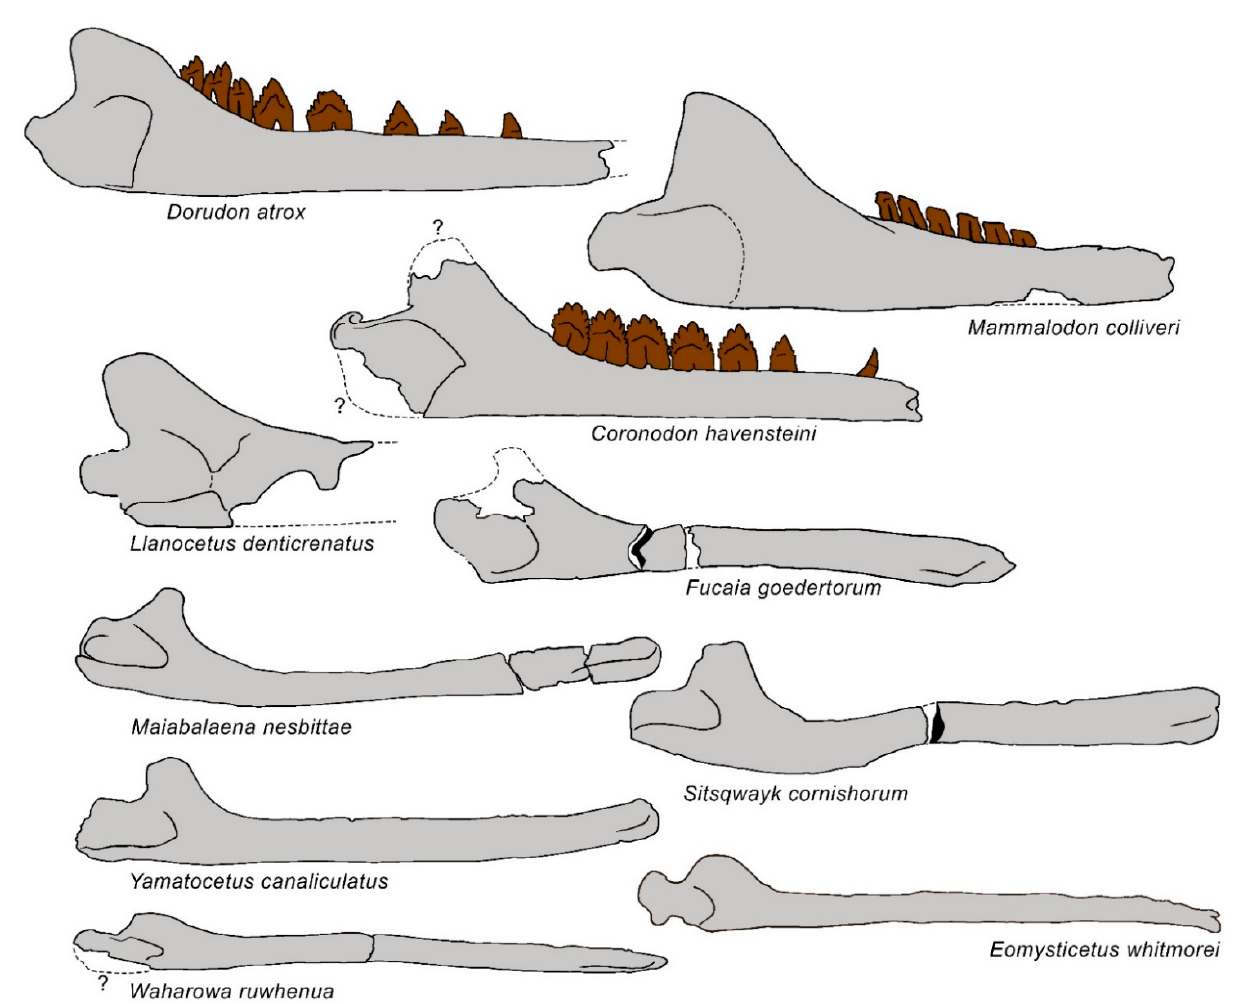
Figure 18. Schematic representations of the dentary of advanced archaeocetes and nonbalaenomorph mysticetes in medial view. Not to scale. Dentaries are represented as if they shared the same anteroposterior length.